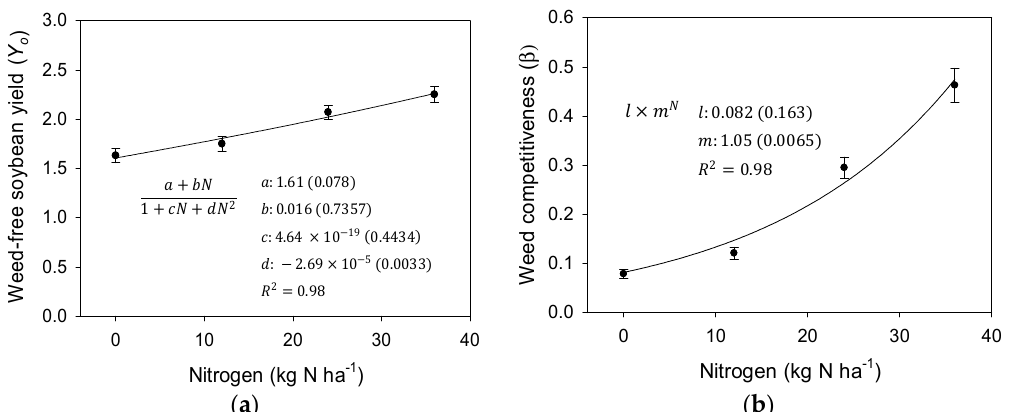
Figure 2. Weed-free soybean yield ( a ) and multiple-weed competitiveness ( b ) as a function of applied nitrogen in the pooled